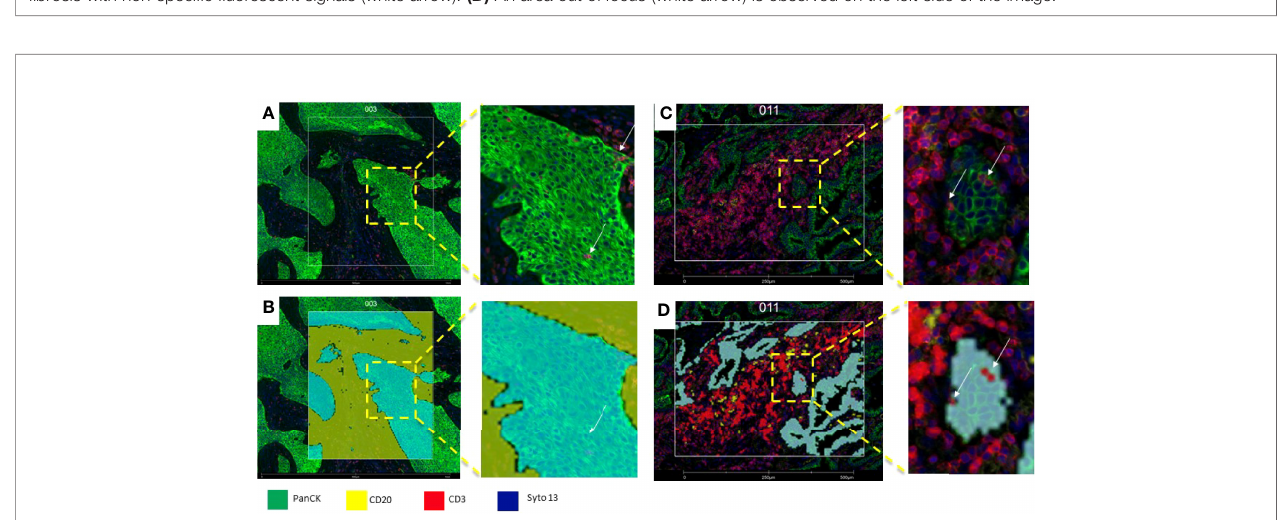
FIGURE 5 | Microphotograph of immuno fl uorescence sections of surgical resected non-small cell carcinoma (A) Squamous cell carcinoma; (B) adenocarcinoma) using DSP assay with PanCK (tumor), CD3 (T-cells), CD20 (B-cells) and Syto13 (nuclei) as visualization markers. (B, D) illustrates different segmentation strategies for tumor, stroma and T cells. In B the segmentation was performed in tumor (cyan mark up) and stroma (yellow mark up) segments based in panCK expression, with this strategy, tumor segments include tumor cells and Intra-epithelial immune cells (white arrows), and stroma segments include all tissue elements among tumor segments (B) , In (C) , segmentation was performed in tumor-(cyan mark up), B-cell (yellow mark up) and T-cells (red mark up) segments based in cell biomarker pro fi le, intra-tumor T-cells (white arrows) are included in the T-cell compartment (D) .